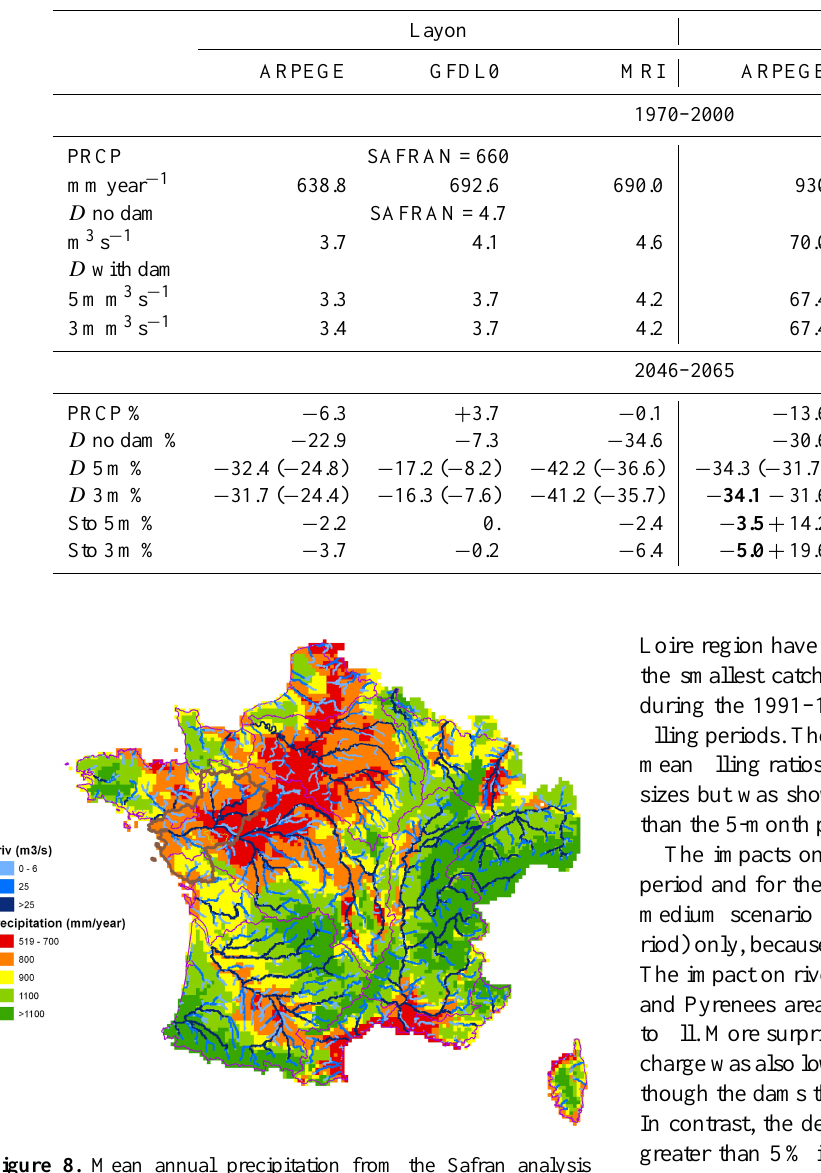
Figure 8. Mean annual precipitation from the Safran analysis (mmyear − 1 ) and mean annual river flow (m 3 s − 1 ) simulated by SIM for the 1970–2000 period. The Pays de la Loire region is out- lined in